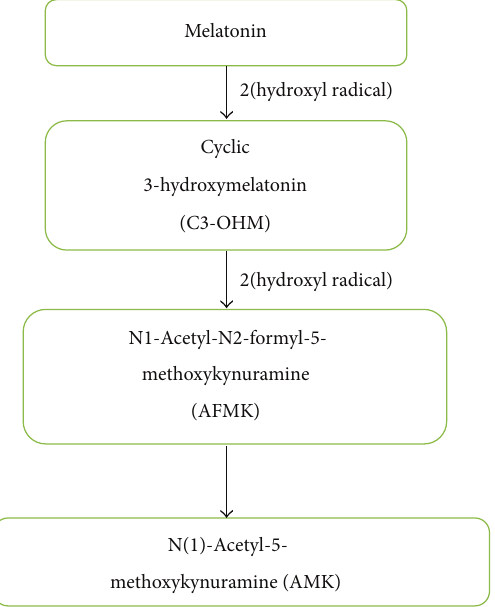
Figure 2: Mechanism for the formation of metabolites by oxidative pyrrole ring cleavage of melatonin forming a primary metabolite AFMK. The secondary metabolite AMK has potent radical scaveng- ing properties as compared to AFMK, formed during the oxidation of melatonin by hydroxyl radicals ( ∙ OH) as a result of pyrrole ring